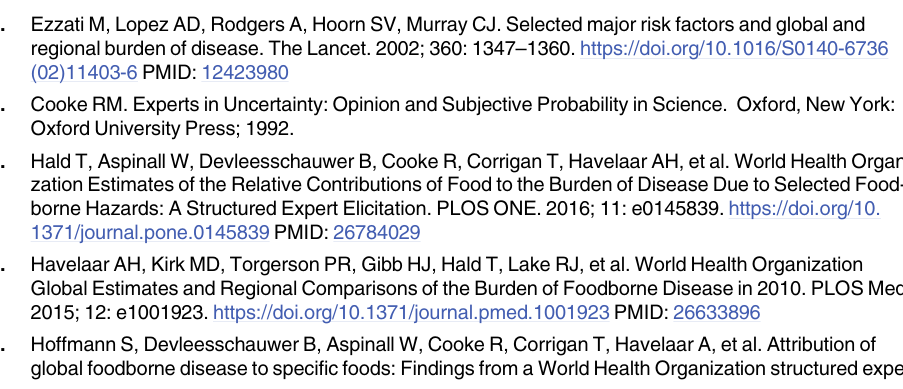
S1 Table. Calibration questions used in the three African countries burden of foodborne disease source attribution expert elicitation. S2 Table. Detailed data for Figs 5–7 and Tables